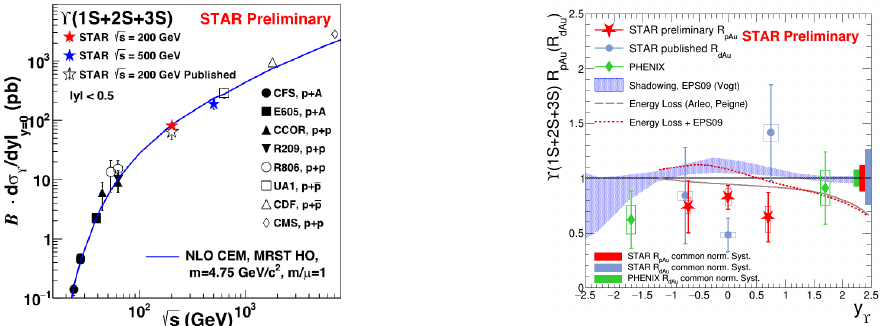
Figure 1. ( left ) Production cross-section B · d σ /d y of the Υ (1S + 2S + 3S) at mid-rapidity in p+p √ s = 200 GeV (red star) compared with world-wide data and NLO CEM calculations [6]. collisions at ( right ) Nuclear modification factor R pAu of the Υ (1S + 2S + 3S) in p+Au collisions at (red stars) as a function of the Υ